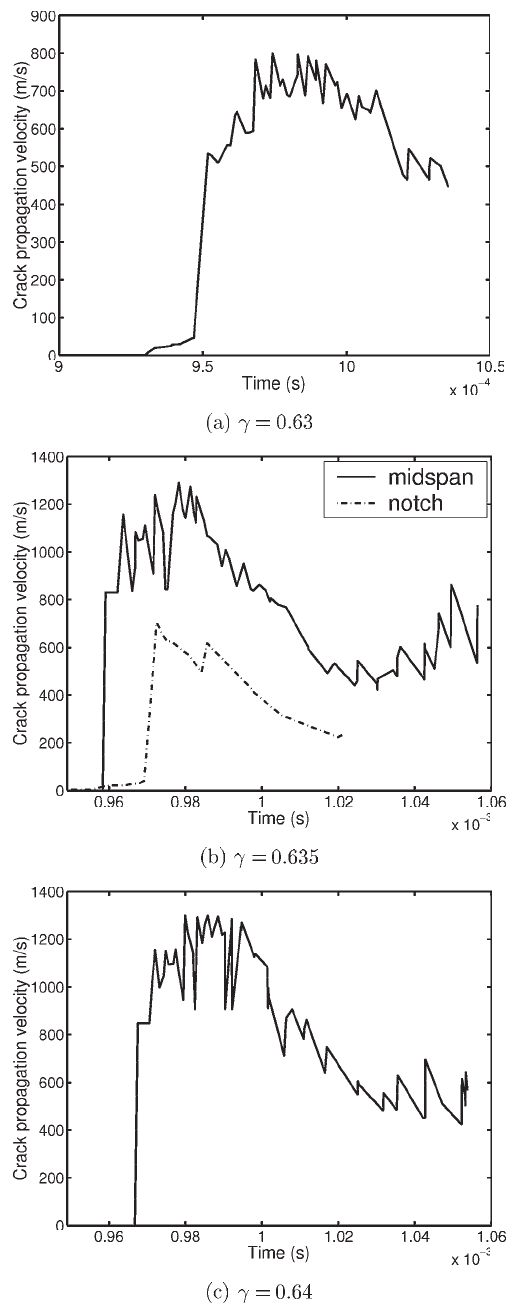
Fig. 11. Crack propagation